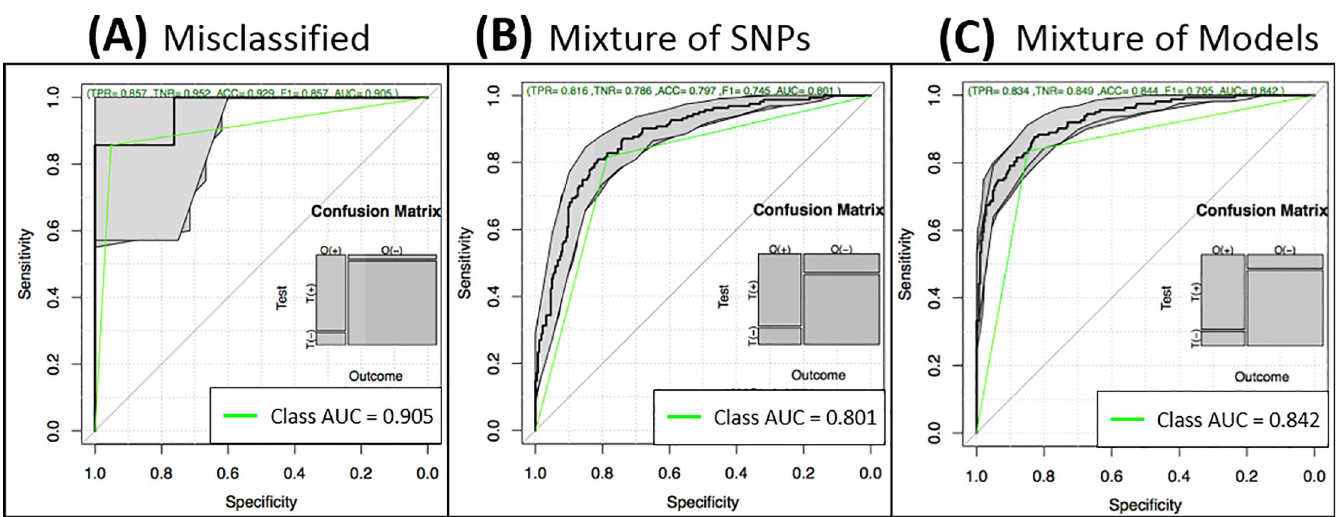
Fig 5. Incorporation of misclassified samples to the predictive model. (A) Performance of the misclassified samples. (B) Performance of the model generated by using the SNPs in T1k and the SNPs from misclassified samples as input for model building. (C) Performance of the model generated by using the SNPs from the T1k LASSO model of Table 1 and the misclassified model as input for model building.